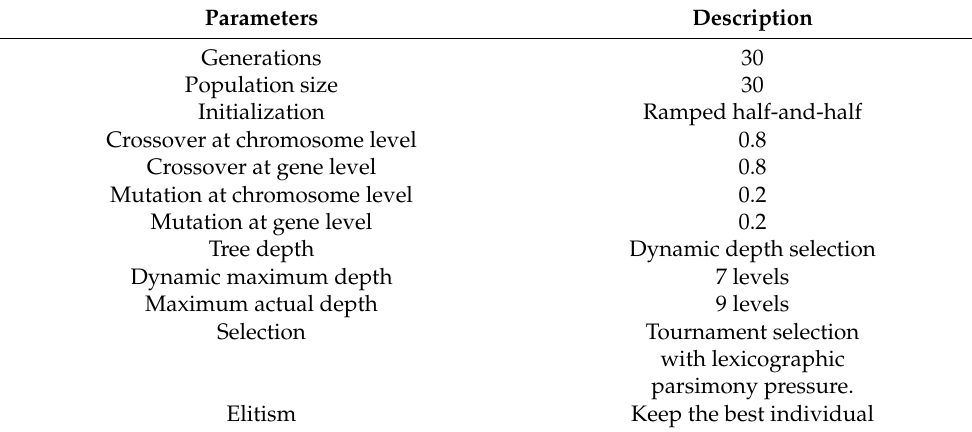
Table 2. Main parameters settings of the BP